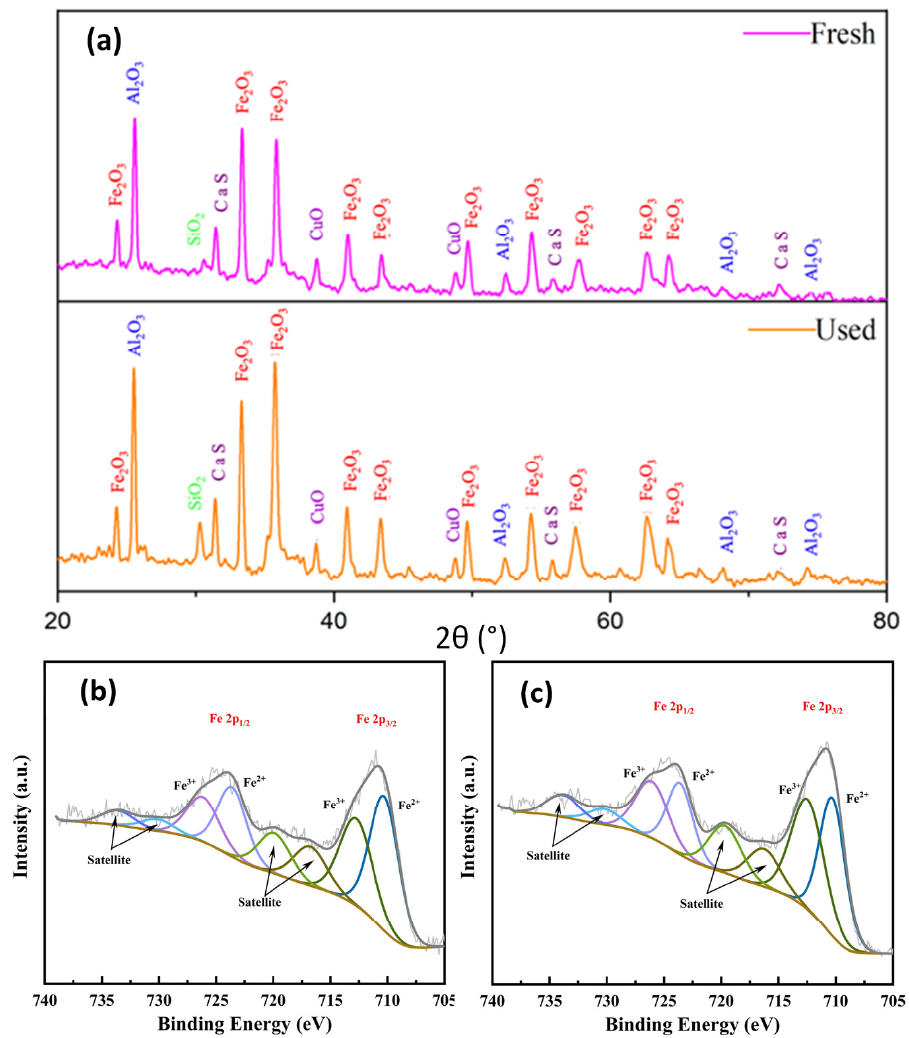
Figure 13. Comparison of the compositions of the fresh and used oxygen carriers: results from ( a ) XRD analyses of fresh and used oxygen carriers, ( b ) XPS analysis for the fresh sample, and ( c ) XPS analysis for the used sample.